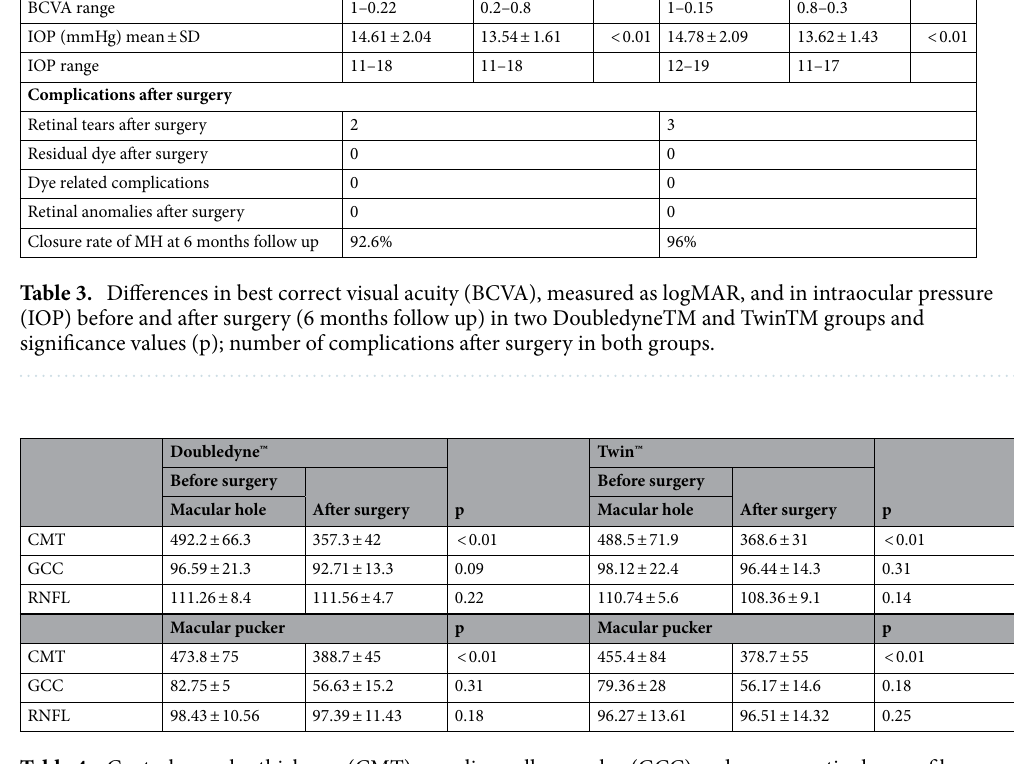
Table 4. Central macular thickness (CMT), ganglion cells complex (GCC) and average retinal nerve fiber layer (RNFL) before and after surgery (6 months follow up), every value is expressed in µm, and significance value